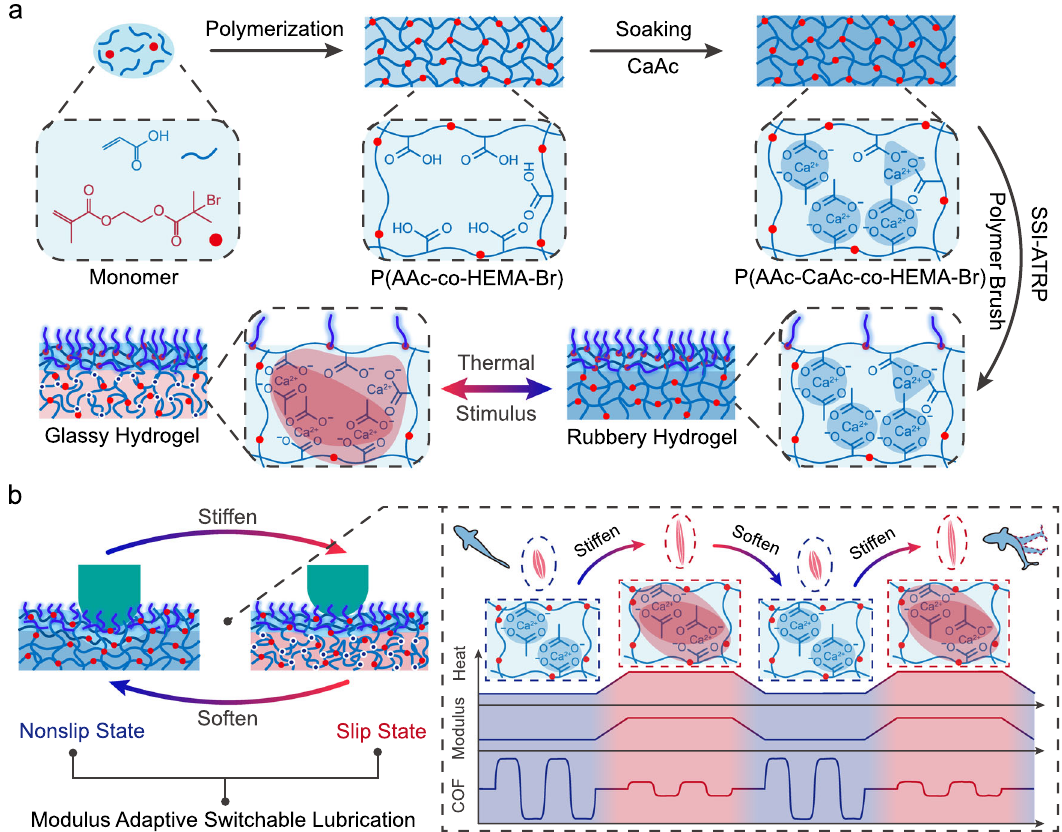
Fig. 2 Preparation and modulus switch mechanism of MALH. a Schematic illustration for the preparation of MALH and thermal-triggered modulus change mechanism. The dark blue fi lled area represented ionic interaction, the dark red and red fi lled area represented the cooperative effects of hydrophobic interaction and the enhanced ionic interaction. b The schematic diagram showing the fi sh-like adaptive switchable lubrication of